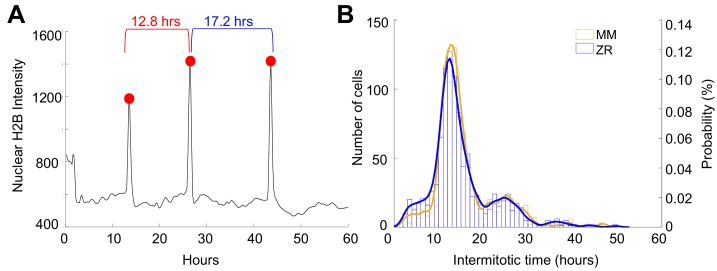
Intermitotic time does not differ between cells grown in minimal medium and Zn2+ replete conditions.(A) H2B intensity of a single cell tracked throughout a 60 hr period. Three mitosis events were detected and marked with a red dot. The intermitotic time (IM) was calculated by determining the difference in hours between each successive mitosis event and indicated above. (B) Intermitotic times for divisions within a 60 hr period of cells grown in either MM or ZR conditions. Histograms show number of cells in each IM time bin and overlaid density plots show the probability of IM times, peaking ~13 hr for both conditions (n = 907 in MM and n = 1000 in ZR, each pooled from four wells).